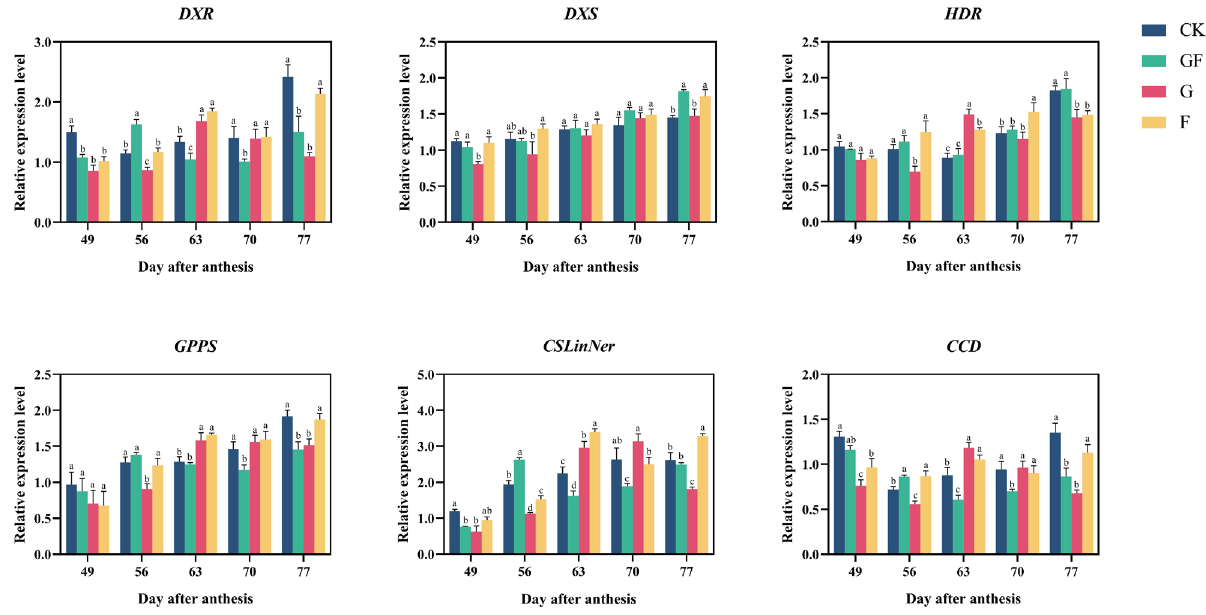
Figure 5. Spatial and temporal expression analysis of terpene-related genes throughout the entire